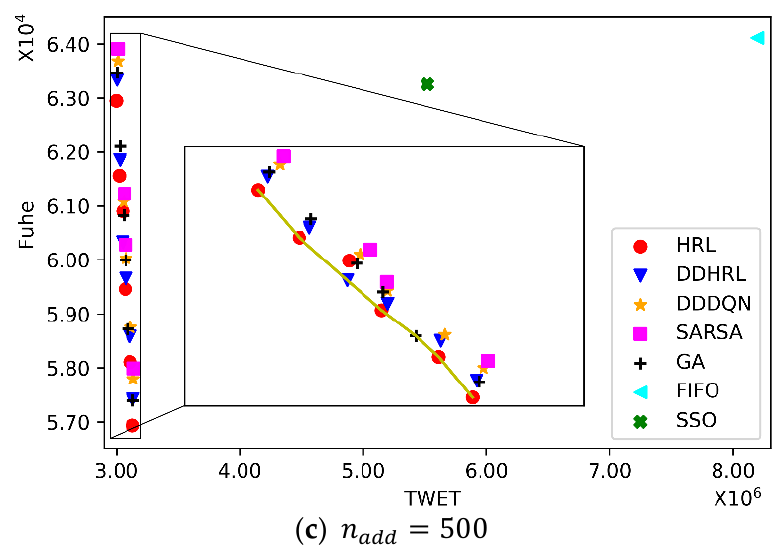
Figure 7. The Pareto fronts obtained by the comparative methods for extended instances.